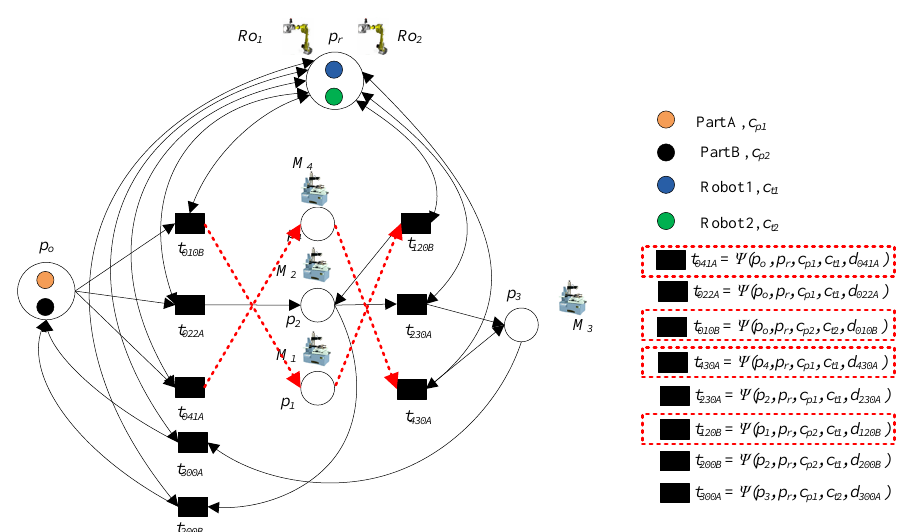
Figure 7. An ICTPN for the reconfigured system by removal of an old machine.